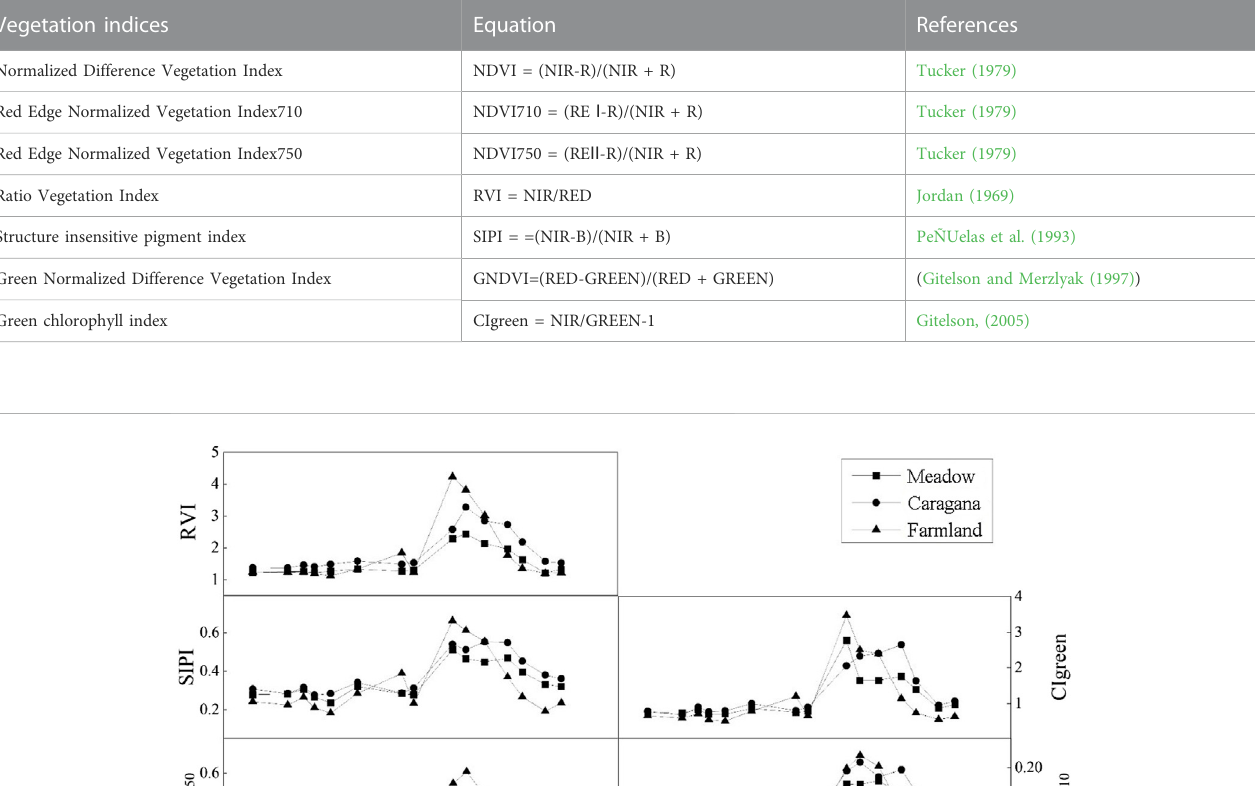
TABLE 4 Vegetation indices, equations, and reference citations.